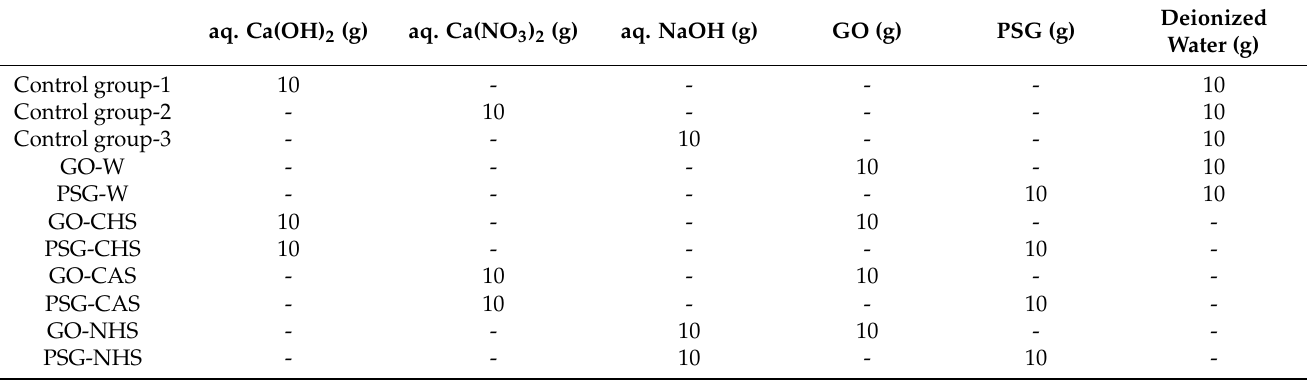
Table 4. Composition of Ion-Concentration Test